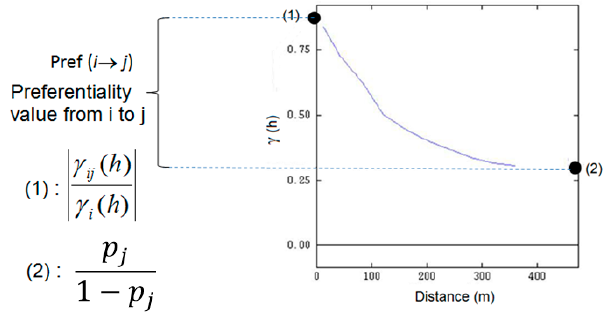
Figure A1. Variogram ratio showing at point (1) the probability of entering the j domain when leaving the i domain and at point (2) the preferentiality value [21].